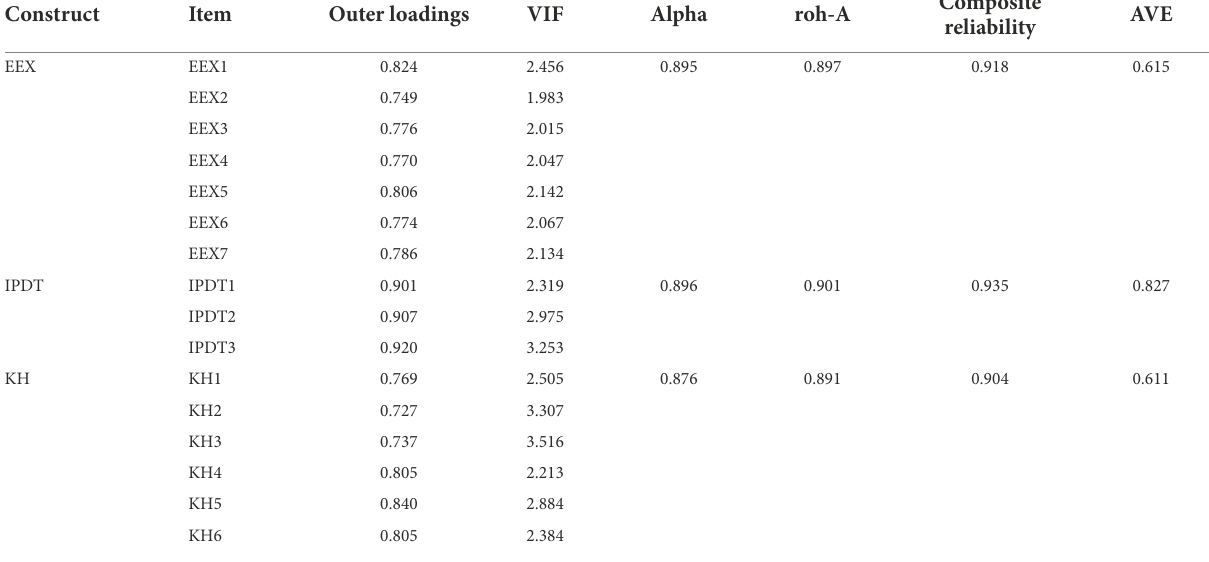
TABLE 1 Reliability and convergent validity of the study constructs (mediation).